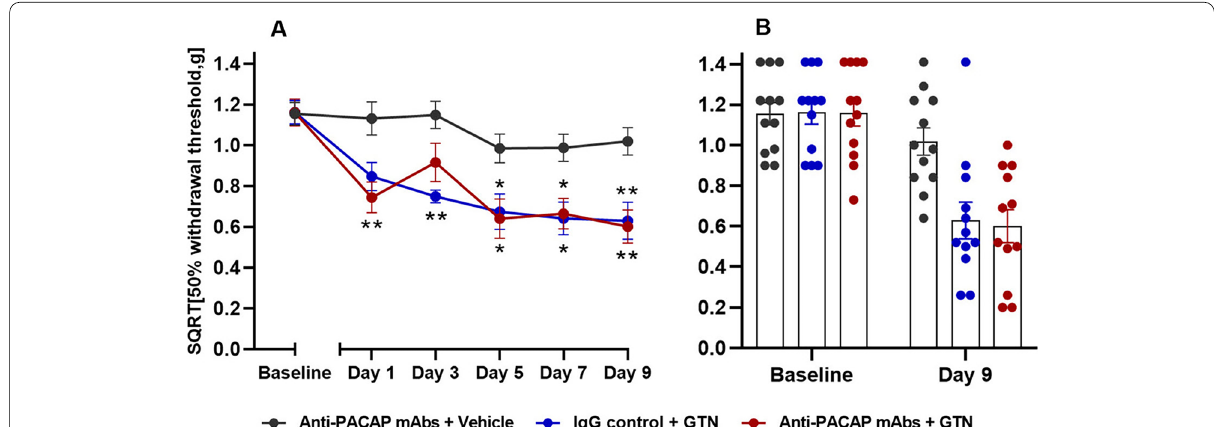
Fig. 3 GTN signaling is independent from PACAP. Data is shown as square root transformed (SQRT)50% withdrawal threshold (g). A Responses two hours after GTN (10 mg/kg, i.p.) or vehicle injection (i.p.) in wildtype mice ( n 12 per group) on five test days. Anti‑PACAP antibody or IgG = control (30 mg/kg, i.p.) was given on day 0. Two‑way ANOVA with Tukey’s post hoc test for multiple comparisons was used with data represented as means SEMs. * P < 0.05, ** P < 0.01, *** P < 0.001, and **** P < 0.0001. B Descriptive visualization of individual data points for baseline and ± = = = = day 9 of the curves on the left‑hand side (Fig. 3A) with mean bars and